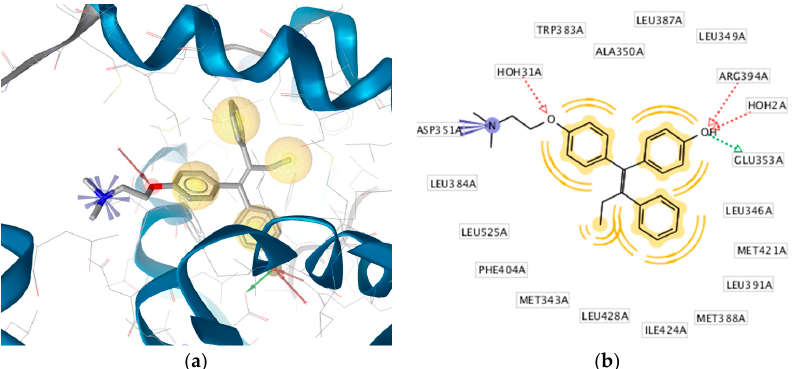
Figure 1. ( a ) Pharmacophore-Molecular Docking Based of 4-OHT with ER α derived from the X-ray